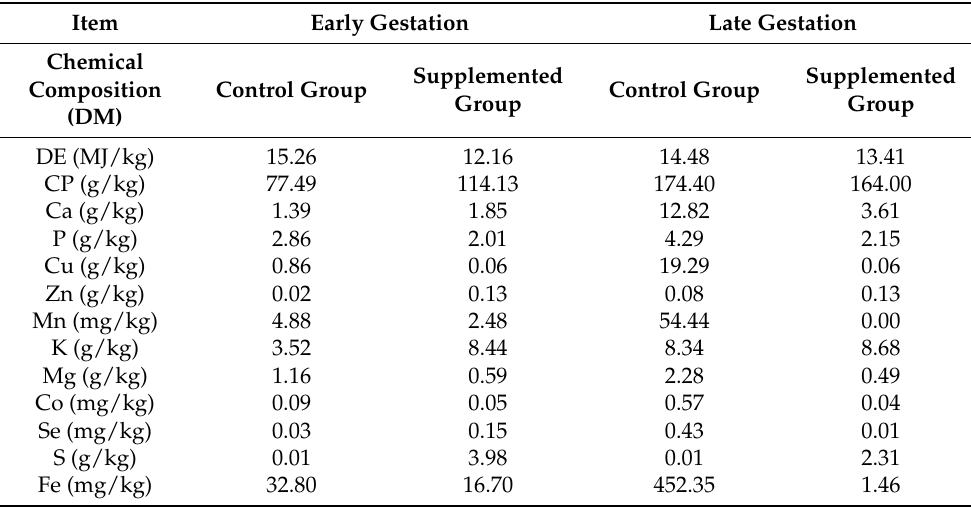
Table 2. Supplementary feed nutrition level in early and late